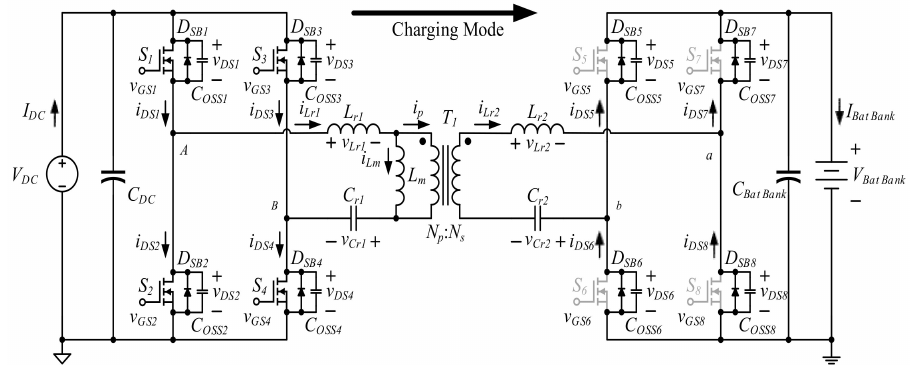
Figure 5. Operating circuit diagram of the proposed bidirectional CL 3 C full-bridge resonant.